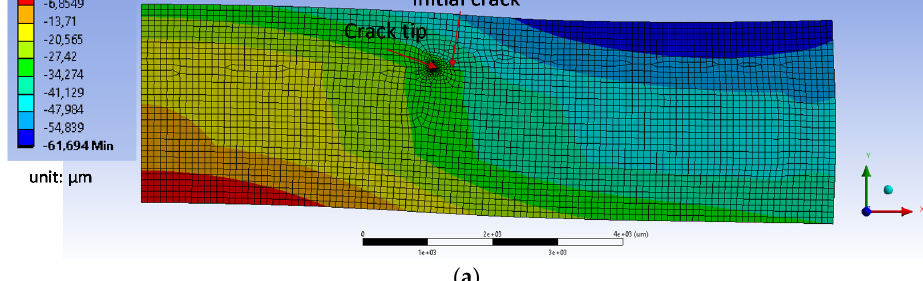
Figure 8. Strain energy release rate (SERR) as function of elasticity of packaging polymer.